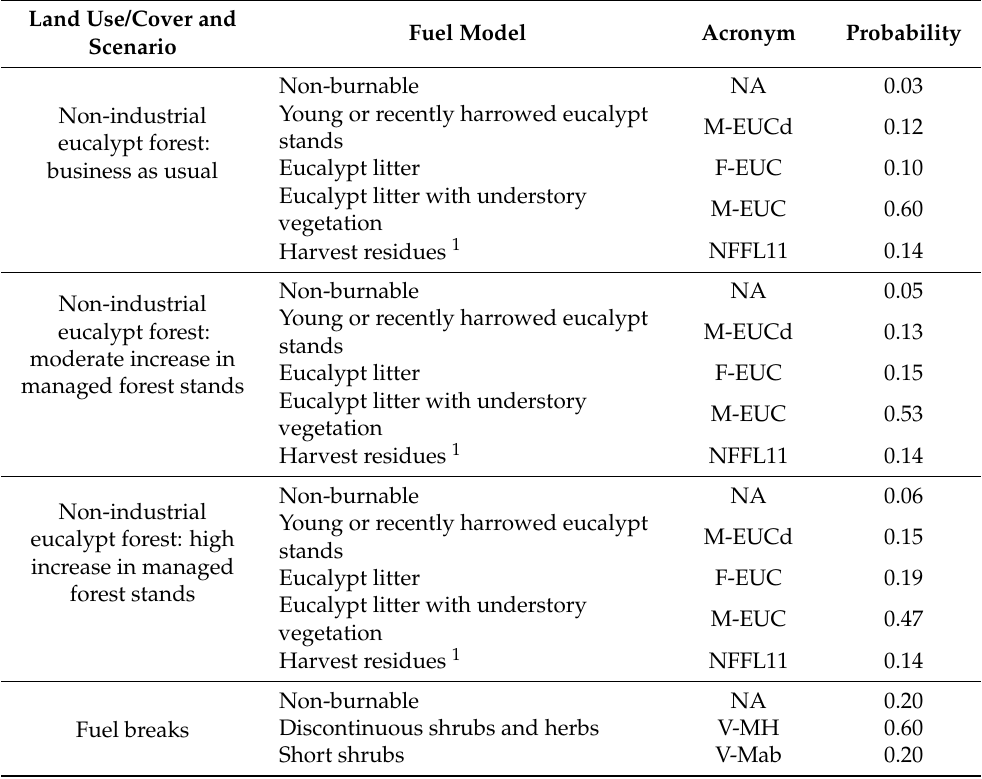
Table 3. Distribution of fuel models in the landscape for each fuel management scenario. Land Use/Cover